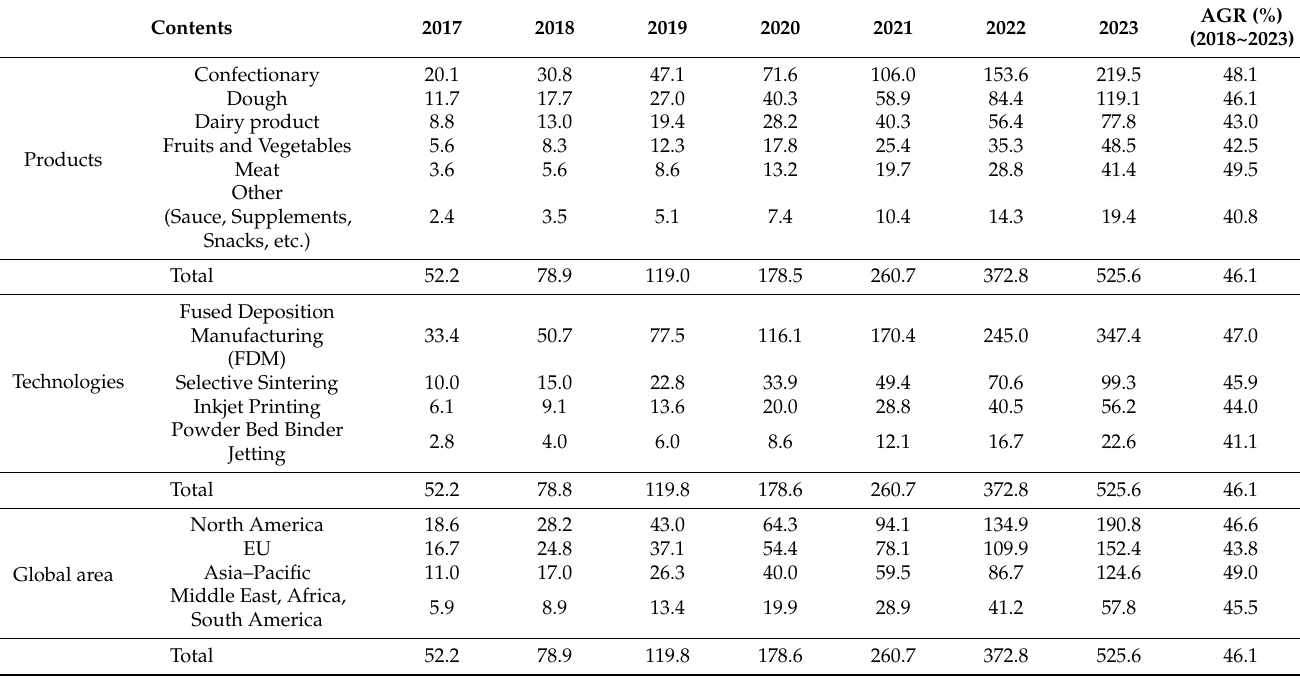
Table 5. Market size by 3D printing around the world. Unit: Million dollar.